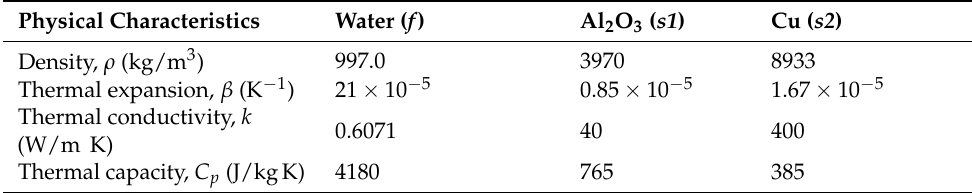
Table 2. Fluid and nanoparticles thermophysical characteristics (see